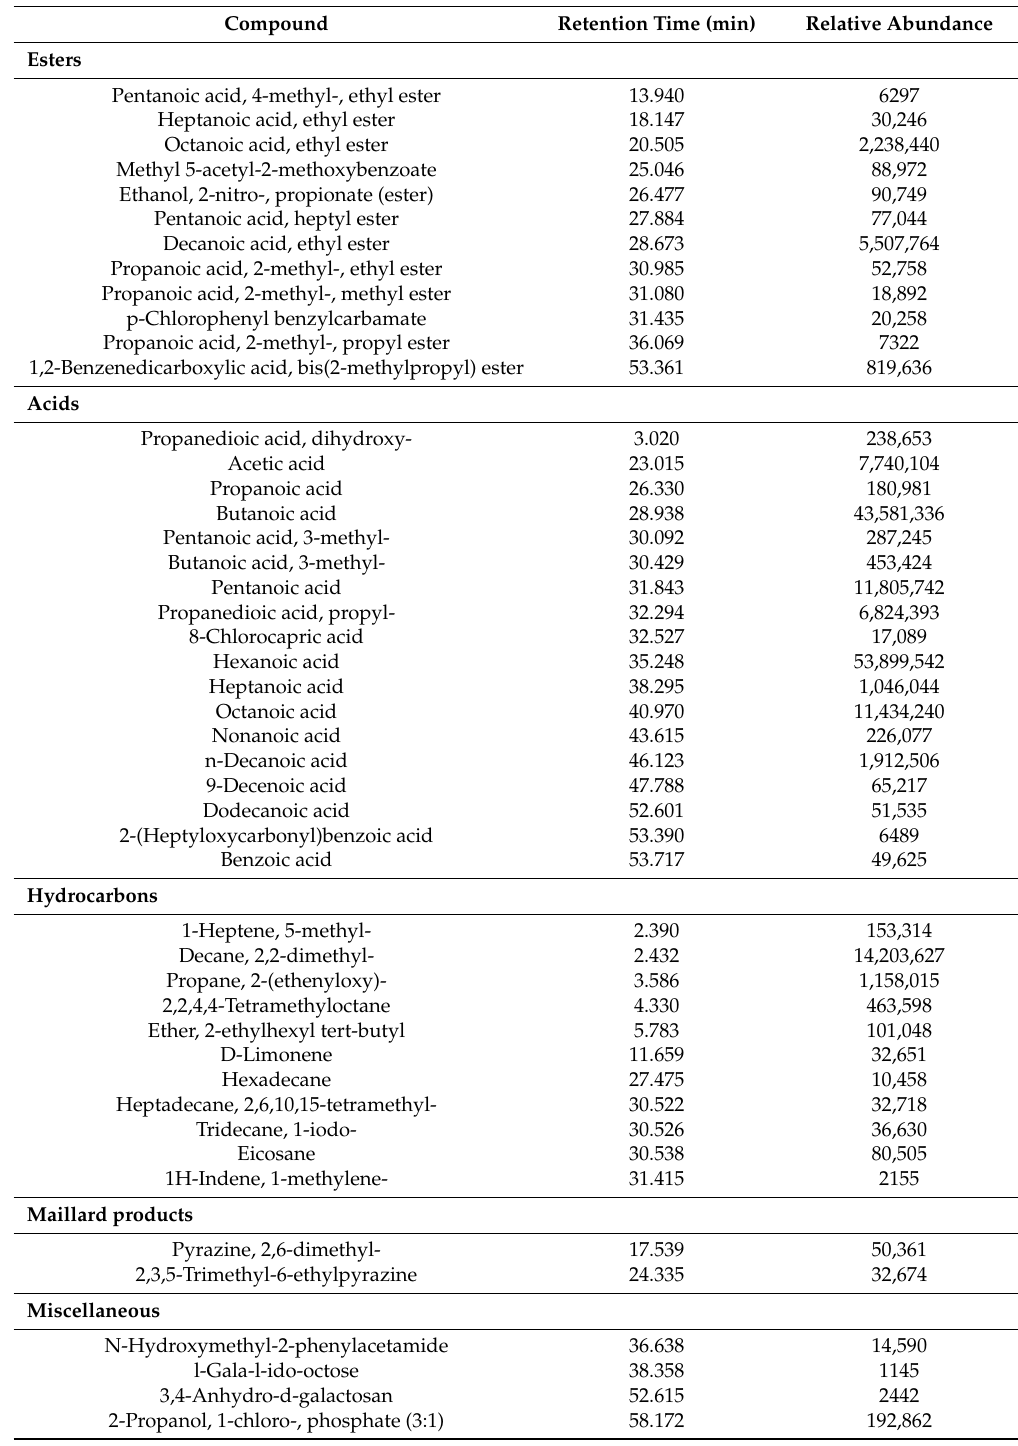
Figure 7 represents a histogram obtained from the SPME-GC-MS analysis showing the aroma compounds of representative undegraded and degraded Parmigiano Reggiano cheese